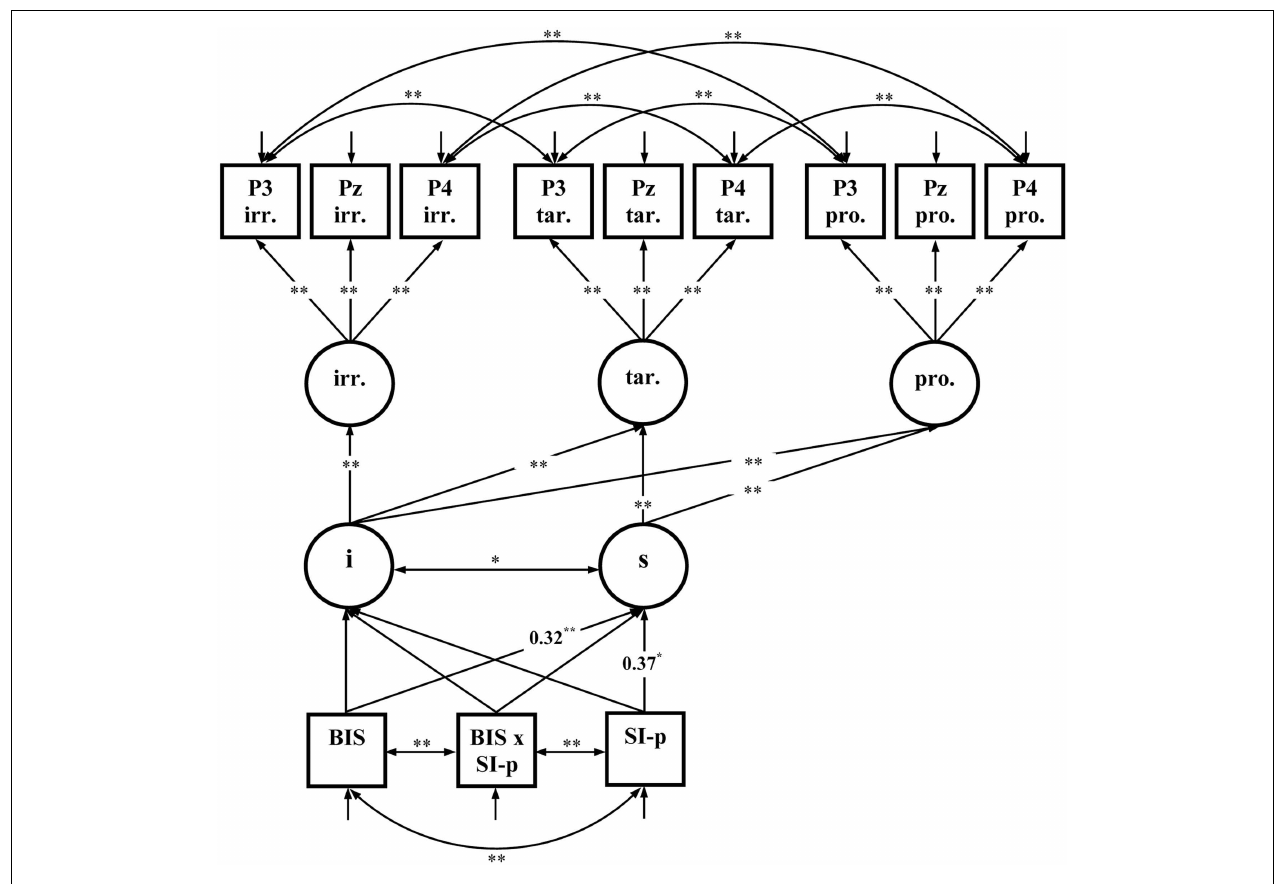
convenience, numerical values of the completely standardized solution are only given for significant coefficients related toTrait-BIS (BIS), SI-perpetrator (SI-p), and theTrait-BIS × SI-perpetrator interaction (BIS ×